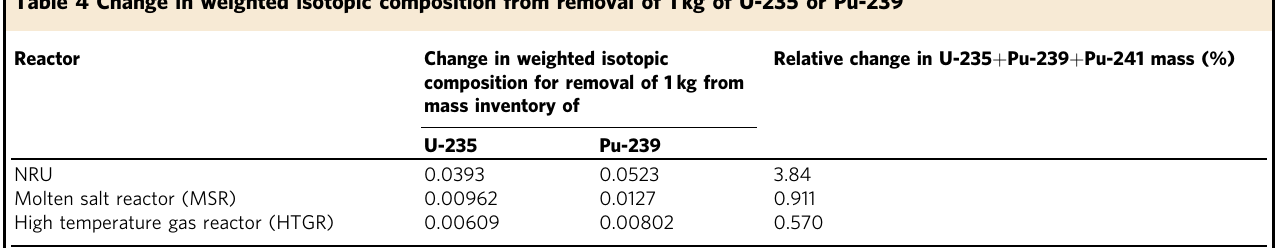
The change in weighted isotopic composition is compared against the corresponding relative change in total sum of U-235, Pu-239, and Pu-241 fi ssile mass inventories. The MSR and HTGR cases are computed after 1 year of burn-up; the NRU case is computed from data during the 2016/09 to 2016/10 time